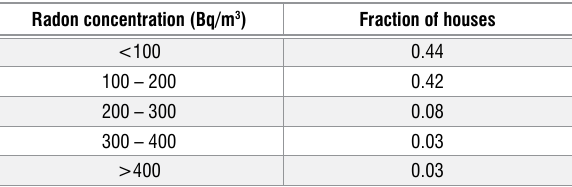
A distribution of the indoor radon concentrations in the granite areas of Paarl 2 Radon concentration (Bq/m 3